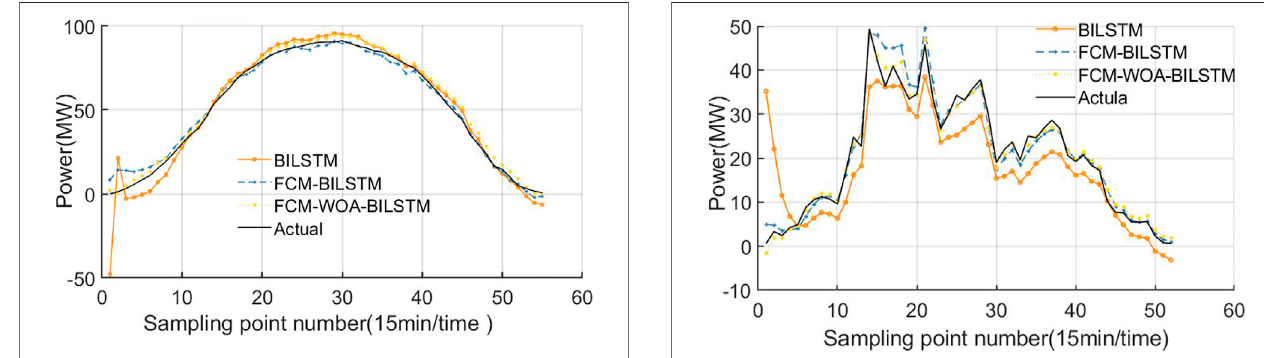
FIGURE 7 | 22 June 2019 (rainy).